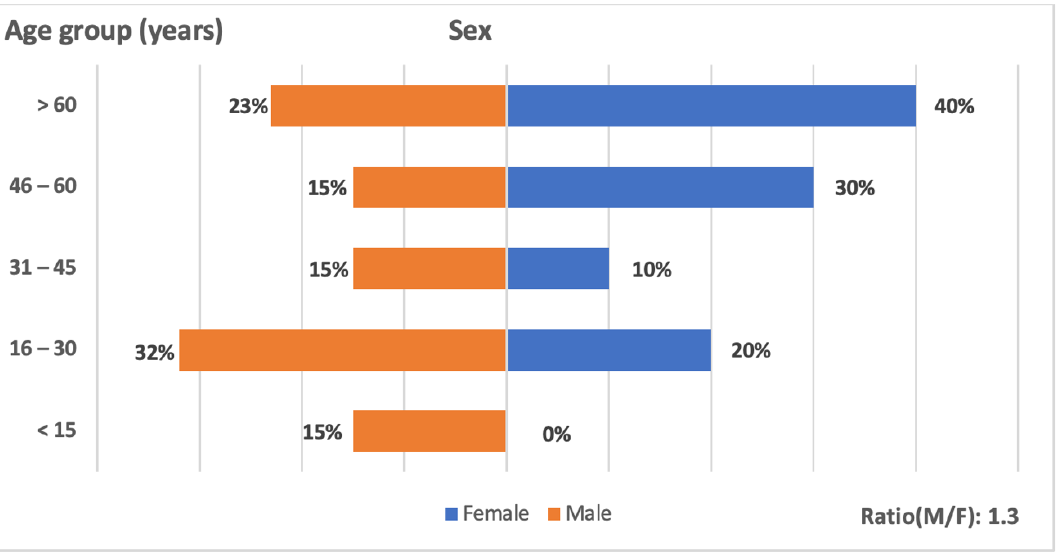
Figure 1. Distribution of WNV cases in Senegal by sex and different age groups, between 2016 and 2021.